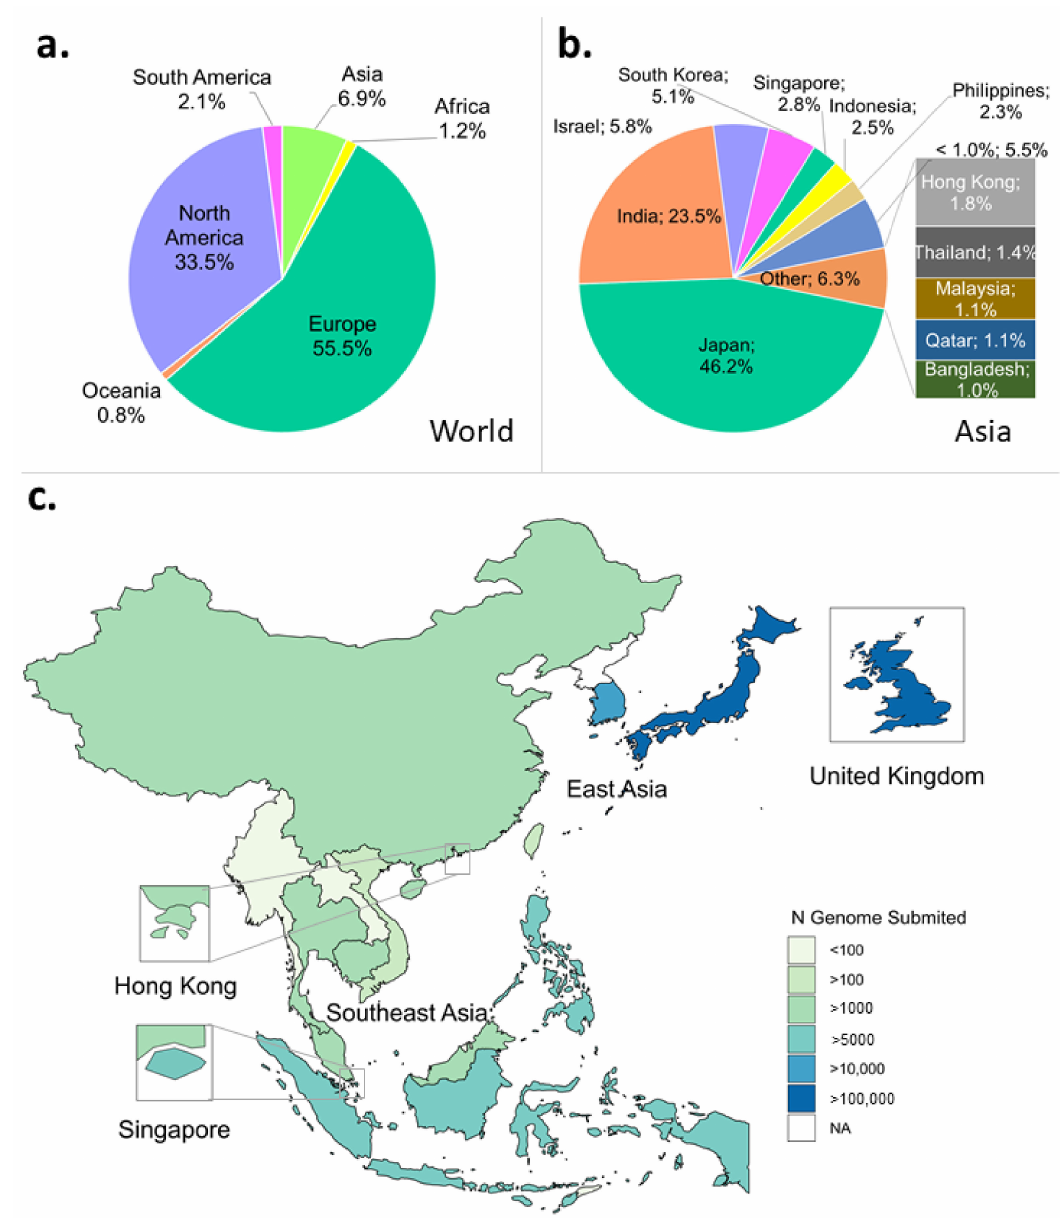
Figure 1. Profiles of SARS-CoV-2 WGS in the world, Asian continent, and East and Southeast Asian region submitted to GISAID. Metadata were downloaded per 1 October 2021. ( a ) Asia only accounts for almost 7% of the total number of submitted genomes compared to the rest of the world. ( b ) In Asia, Japan is the country with the highest number of submitted genomes. ( c ) Distribution map of the number of genomes submitted to GISAID in ASEAN, East Asia region, and the